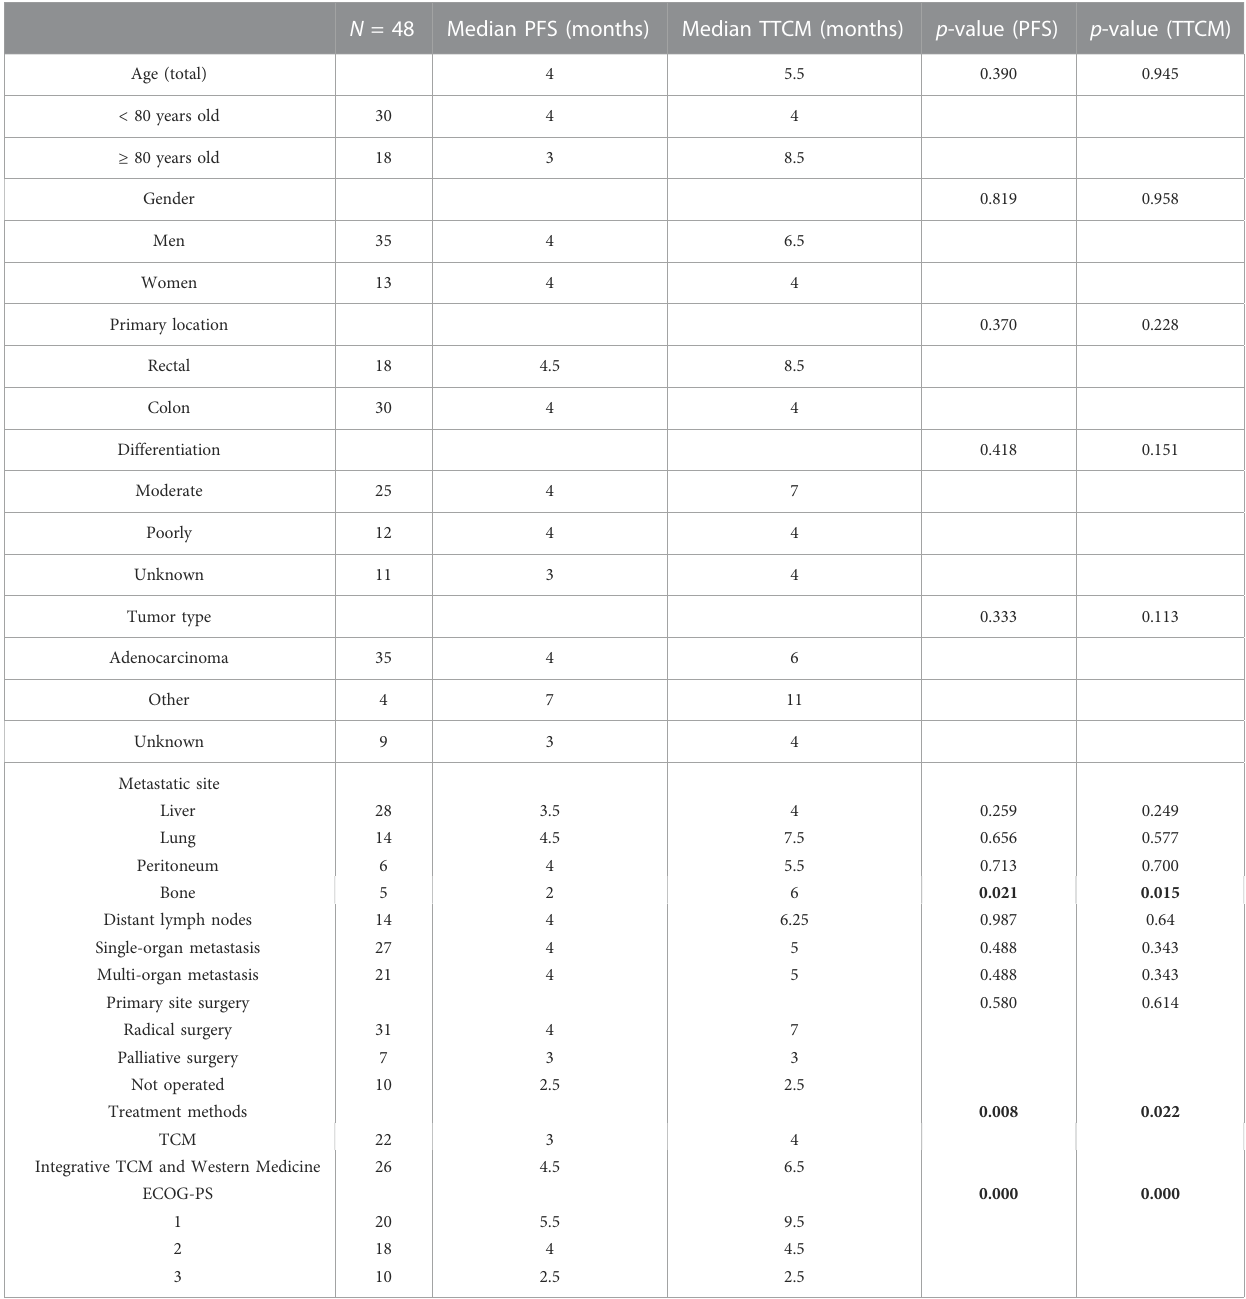
TABLE 2 Subgroup analysis of PFS and